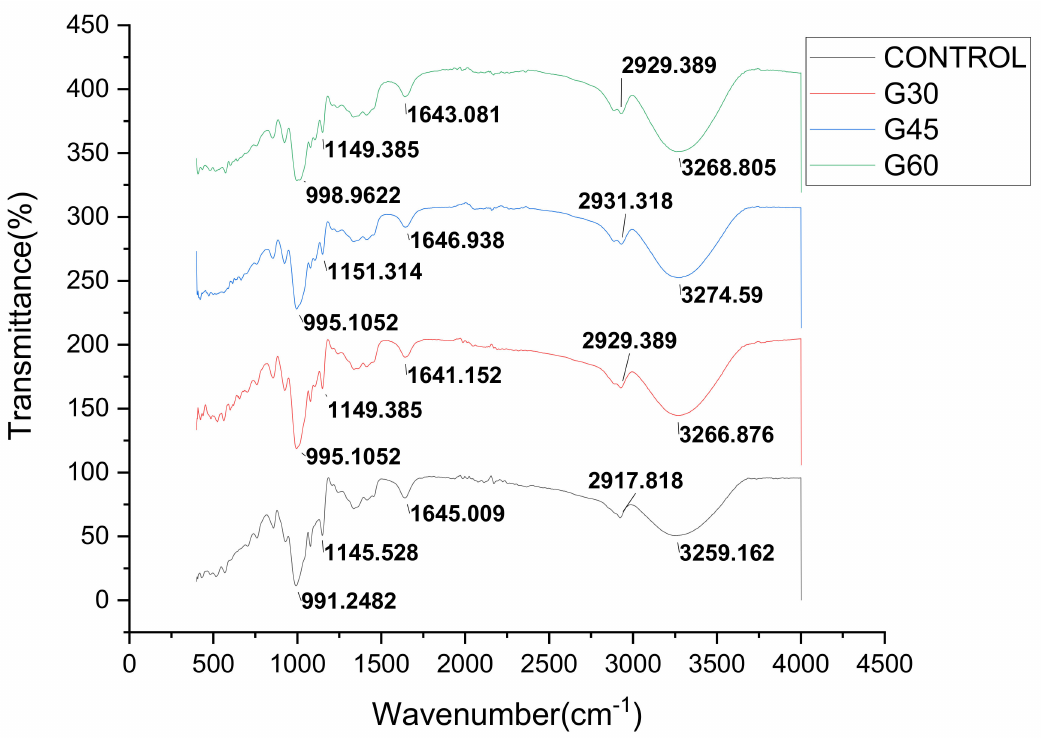
Figure 8. FTIR curves of CS films with various glycerol concentration.